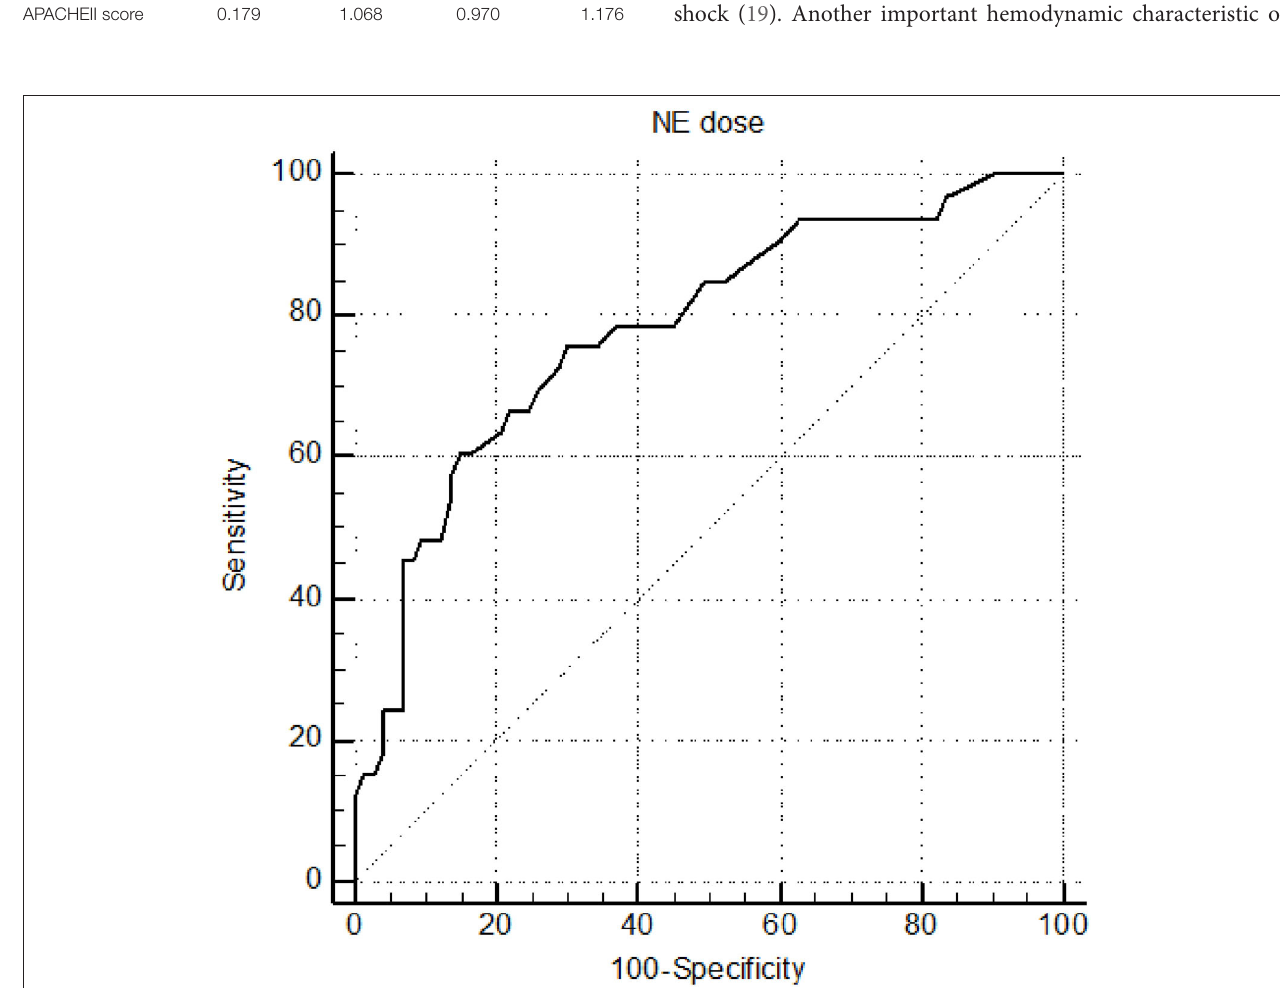
FIGURE 2 | Receiver operating characteristic curve for NE dose for predicting 6-h lactate clearance.